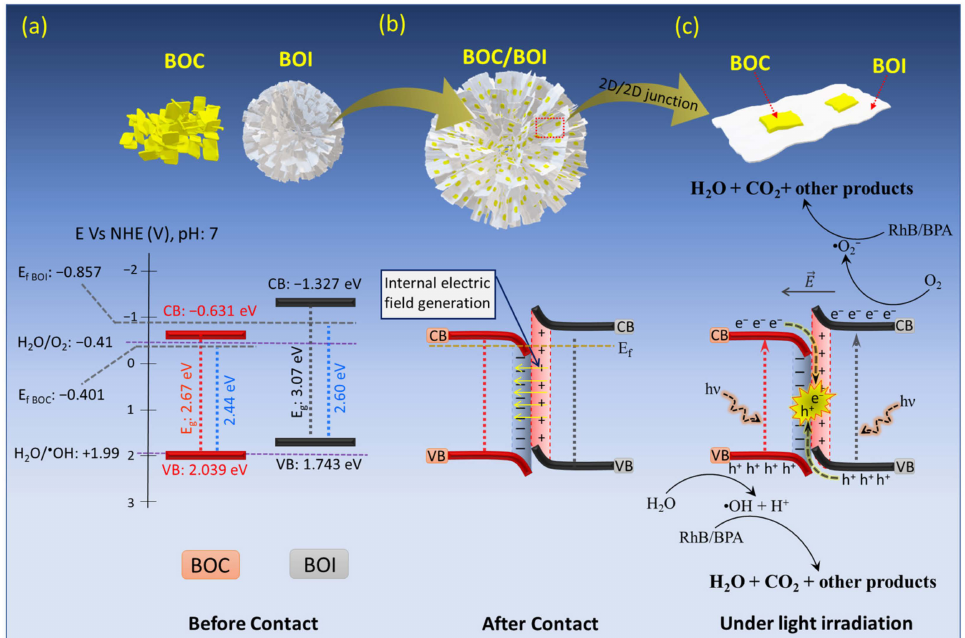
Figure 11. Schematics and energy-level diagrams of ( a ) BOC and BOI before contact, ( b ) IEF formation at BOC and BOI interface after contact, and ( c ) interfacial charge transfer behavior in BOC/BOI-3 heterostructure under visible-light